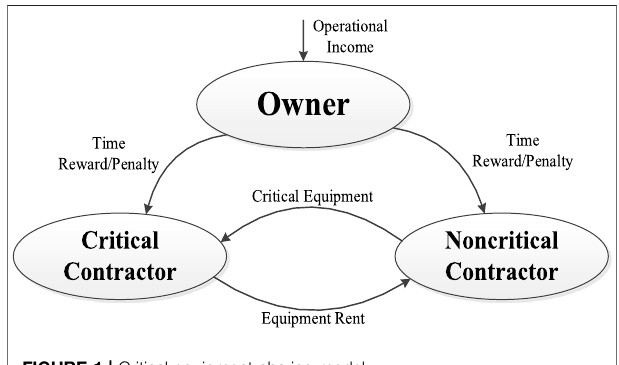
FIGURE 1 | Critical equipment-sharing